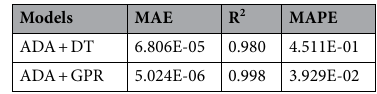
Table 2. Final Model